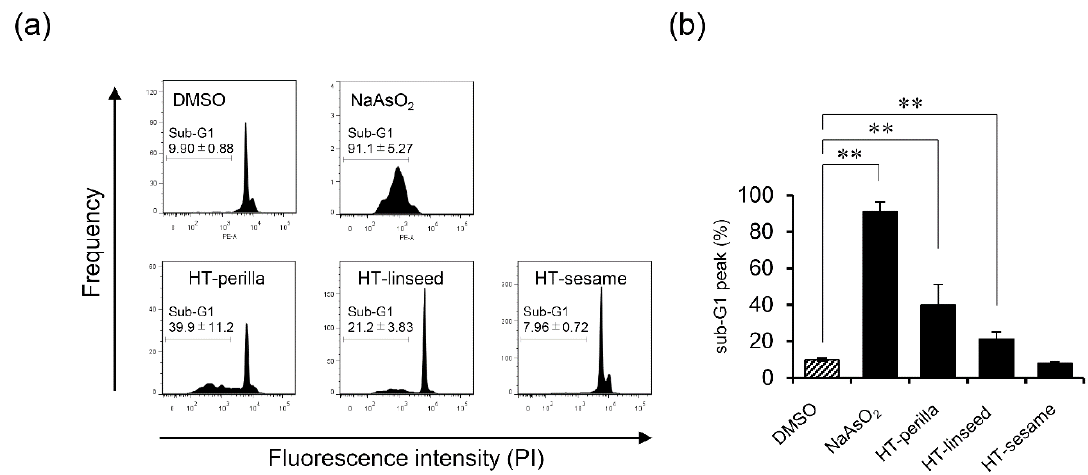
Figure 3. Heat-treated oils induced DNA fragmentation in SH-SY5Y cells. SH-SY5Y cells were incubated with heat-treated oils (3 d, 1 mg/mL) for 24 h. ( a ) After exposure to heat-treated oils, cells were fixed and stained with PI, and then the sub-G1 peak was examined by flow cytometry. NaAsO 2 (1 mM) was used as an apoptosis-inducing positive control reagent. Representative histograms from at least three experiments are shown. ( b ) Percentage of sub-G1 peak. One-way ANOVA with Dunnett’s test was used. ** p < 0.01 compared with control (DMSO). Results are expressed as mean ± SD (n = 3).